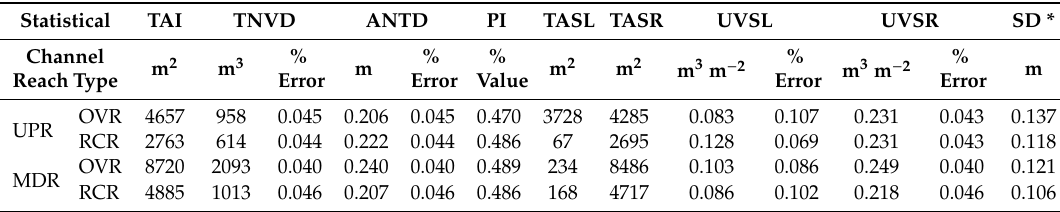
Figure 7. Surface elevation di ff erences (m) found for the Upper (UPR) and Middle (MDR) RCR, using HRDTM derived from SfM-MVS, for the period September 2018 to September 2019, including the events of 18 November 2018 and 19–20 April 2019. Table 1. Statistical descriptors relating to the morphological sediment budgets calculated for the overall (OVR) and reference channel reaches (RCRs) in the UPR and MDR for the period September 2018 to September 2019 (SfM